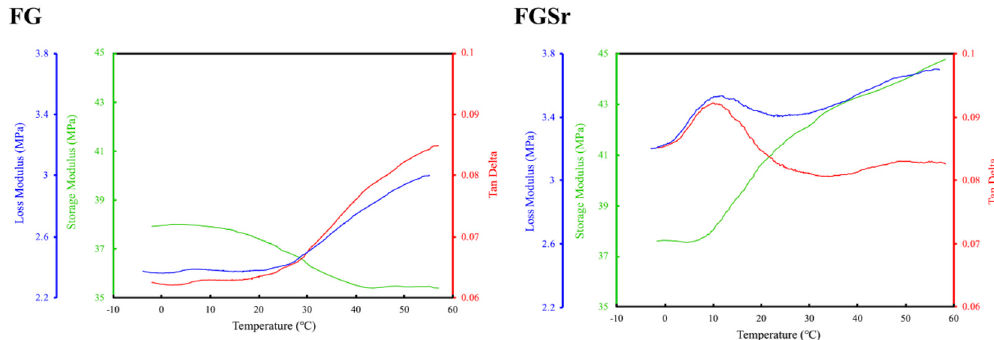
Figure 3. Dynamic mechanical analysis curves of 3D-printed FG and FGSr scaffolds at loss modulus, storage modulus, and tan δ .